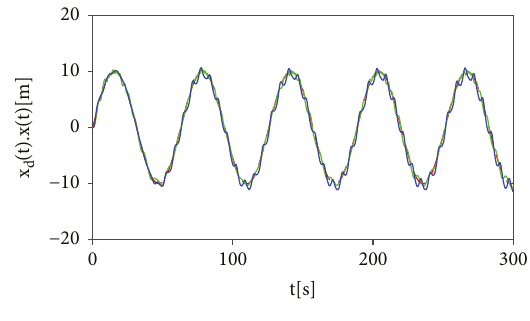
Figure 14: Position tracking trajectory.